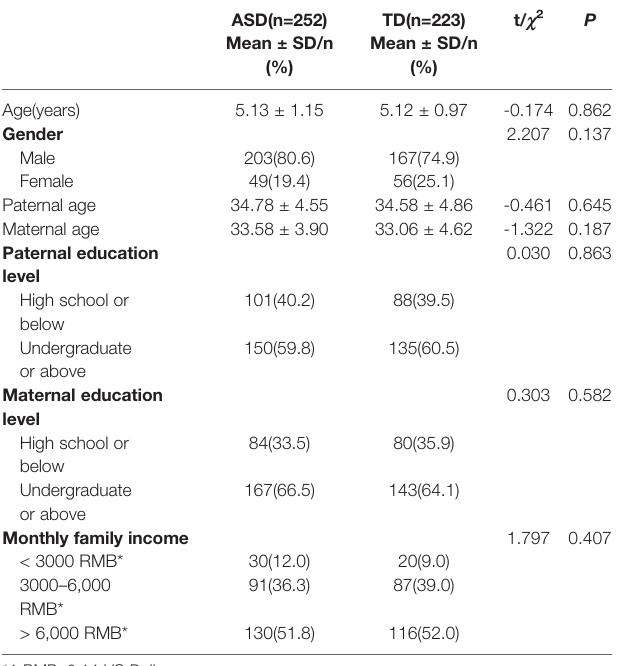
TABLE 1 | Sociodemographic characteristics of participants.